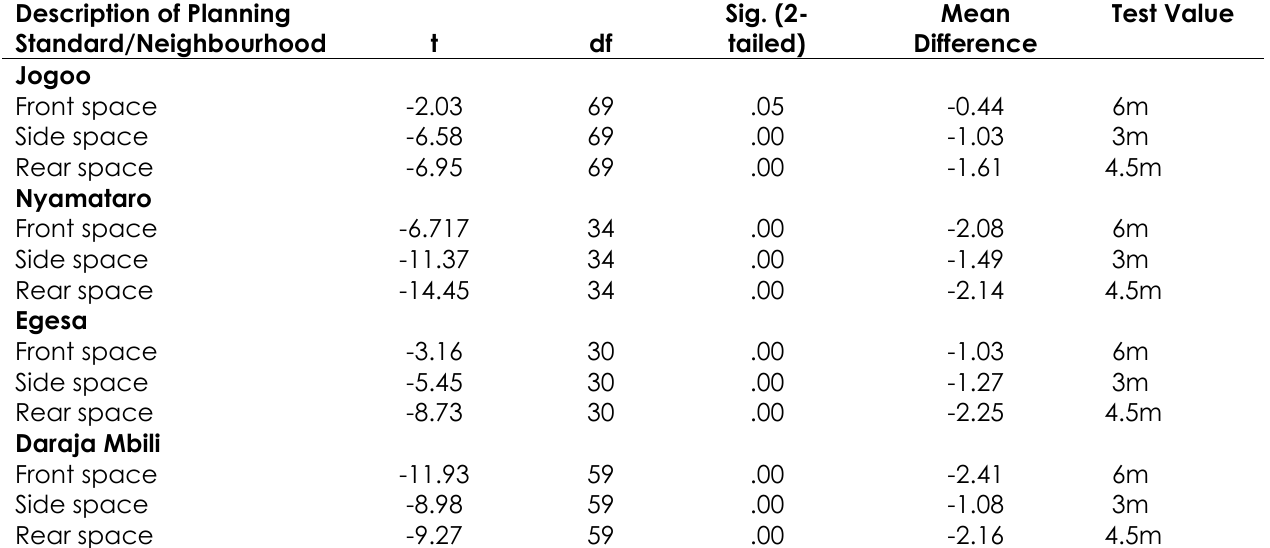
Table 3: One-sample test on compliance in Jogoo, Egesa, Nyamataro and Daraja Mbili Description of